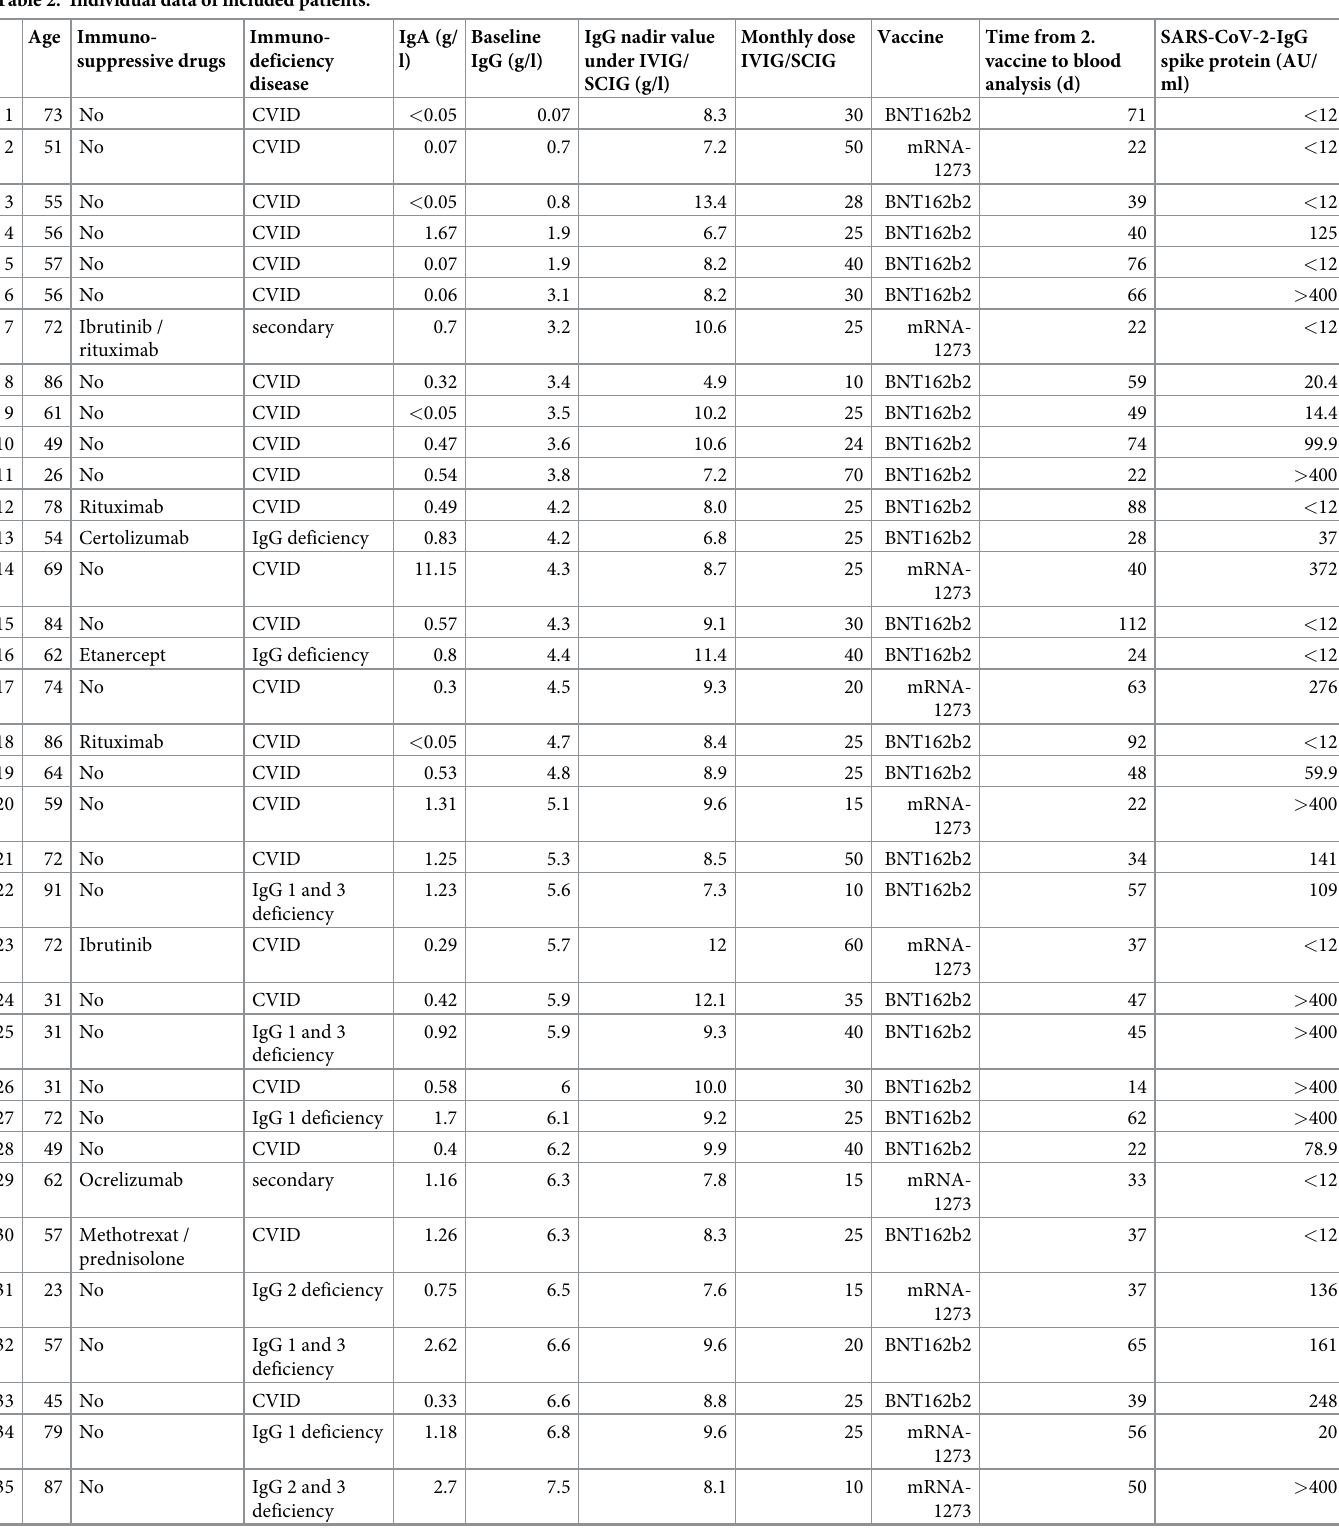
Table 2. Individual data of included